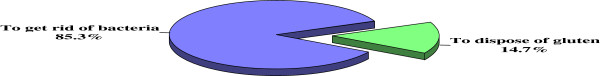
Knowledge about importance of hand washing after dealing with gluten substances.